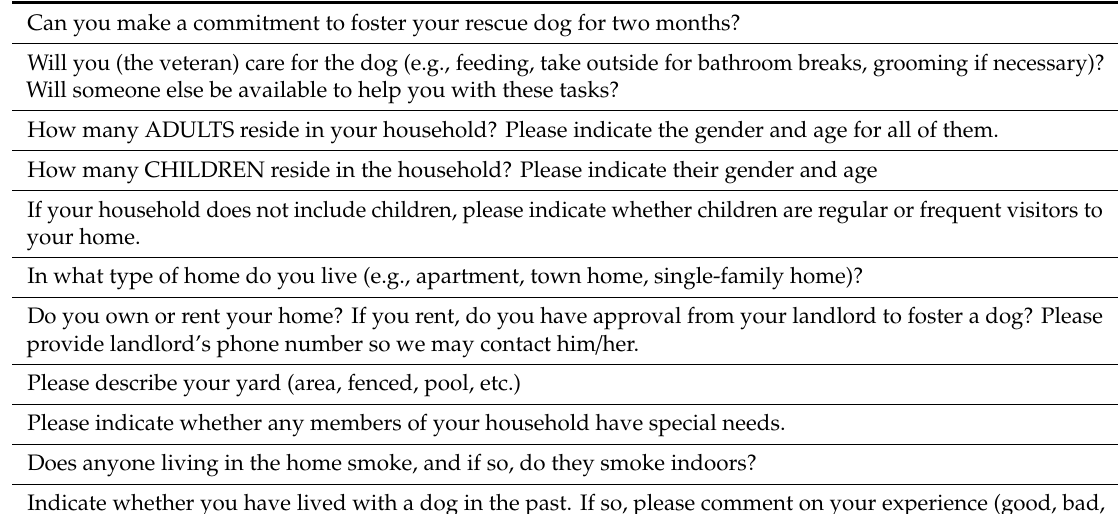
Table A1. Foster application